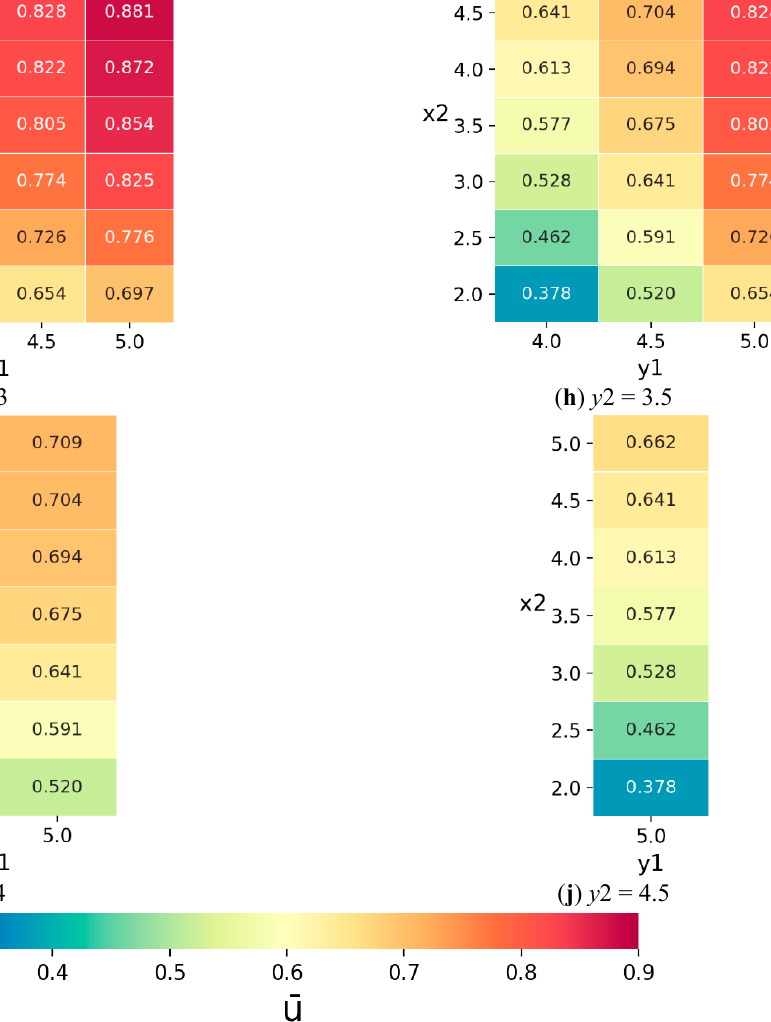
Figure 9. The heat maps of average inflow velocity. Each map corresponds to a fixed y 2. The color and the number inside represent the value of the average inflow velocity.